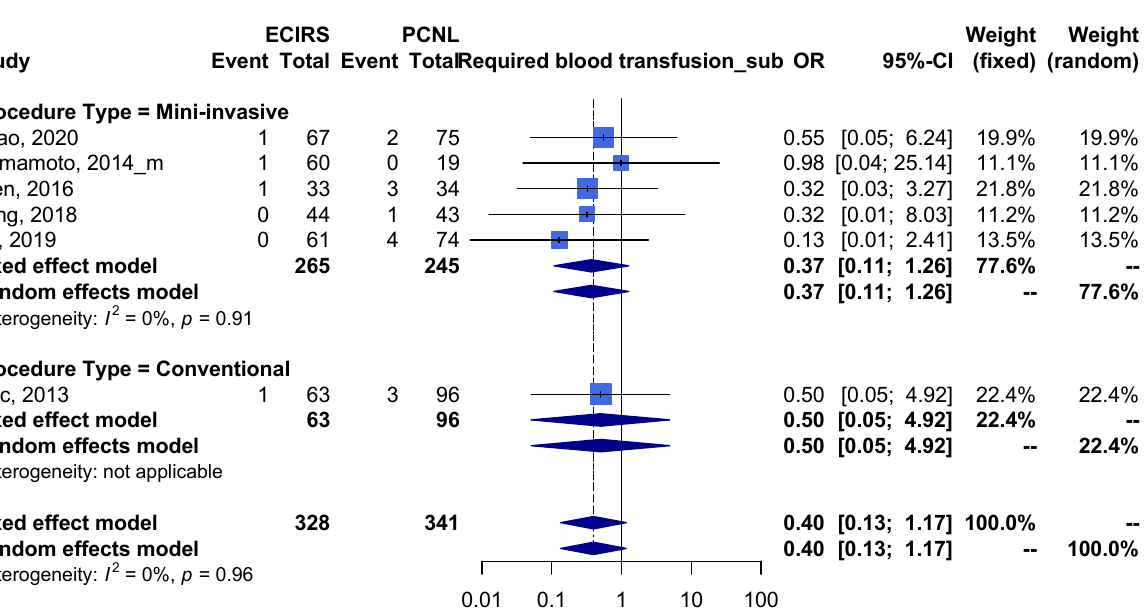
Figure A7. Subgroup analysis of outcome regarding required blood transfusion. (Mini: [17–19,22,23]; Conventional: [21])